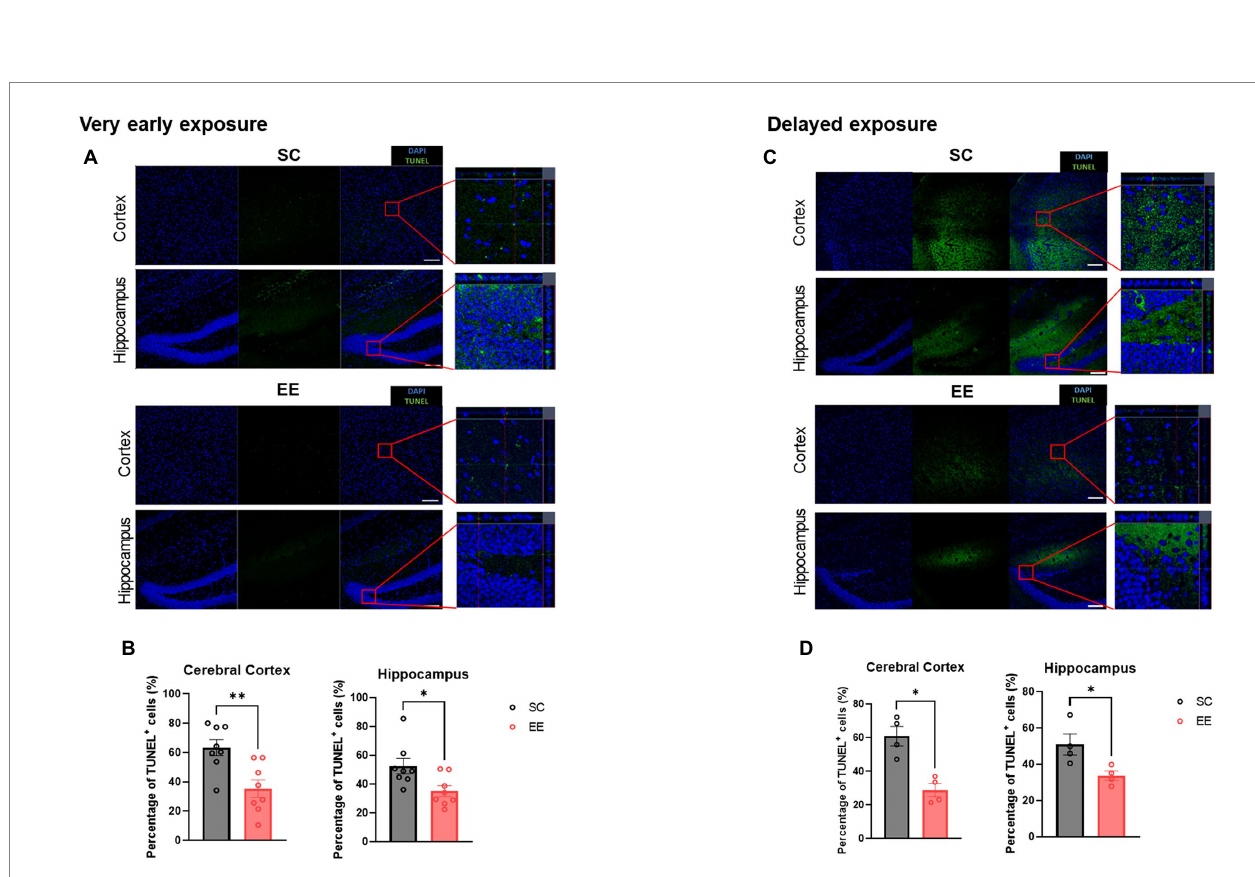
FIGURE 6 Very early and delayed exposure to EE decreases TUNEL immunopositivity in the cerebral cortex and the hippocampus. Representative TUNEL images from the very early exposure EE group and its control group are shown in (A) , and the corresponding quantification is shown in (B) ( n = 8 per group). Representative TUNEL images from the delayed exposure group and its control group are shown in (C) , and the corresponding quantification is shown in (D) ( n = 4 per group). All statistical comparisons were performed via Student’s t-tests. Data represented are means ± SEM. * p < 0.05, ** p < 0.01, and *** p < 0.001. EE, environmental enrichment; TUNEL, terminal deoxynucleotidyl transferase dUTP nick-end